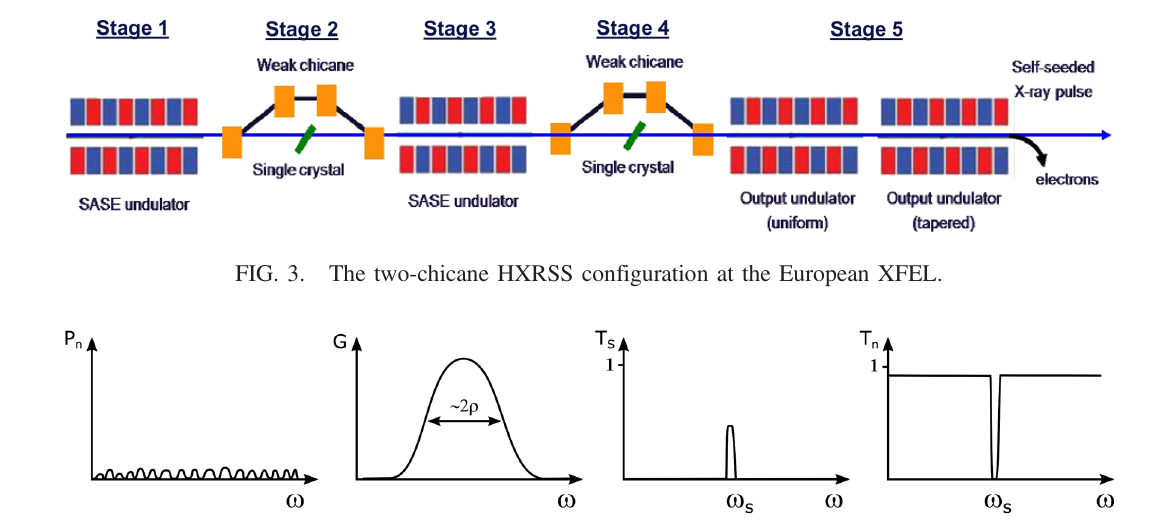
FIG. 4. Illustrations (left to right): equivalent shot-noise spectrum and transfer functions of the FEL process, effective crystal filter and crystal transmission.